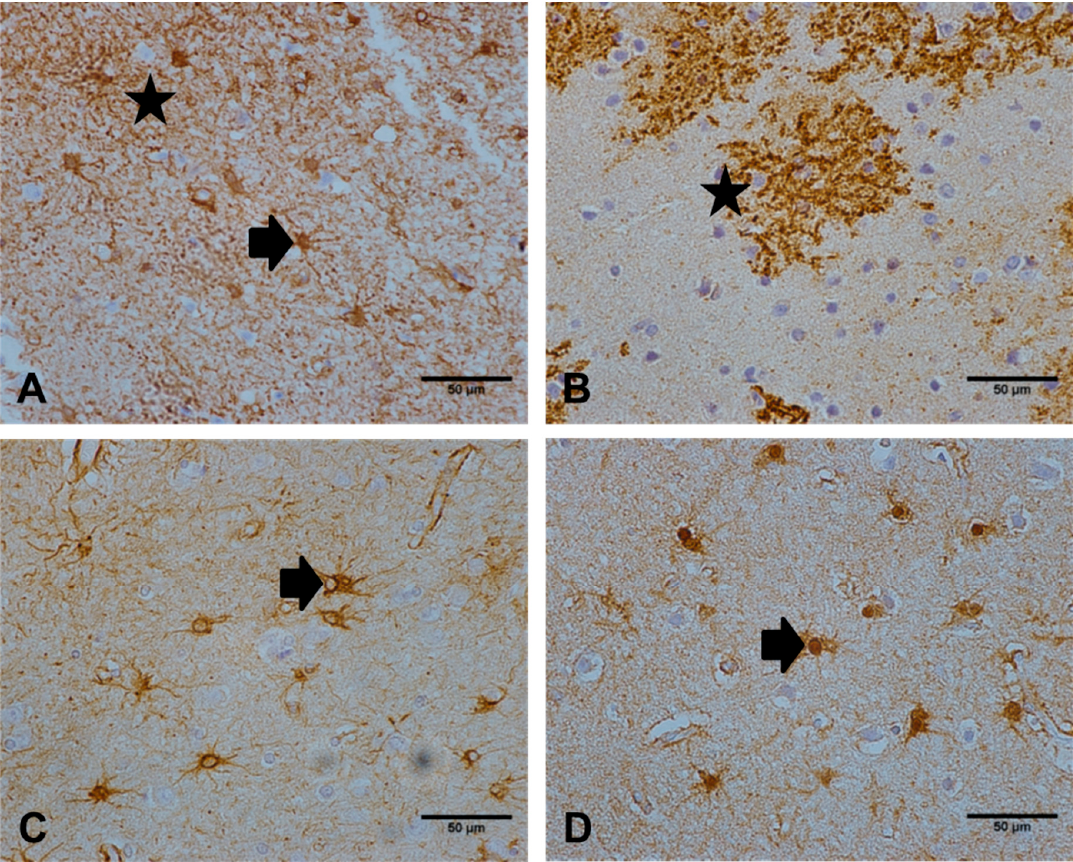
Table 1. Comparison of the immunoreactive profile (% area immunoreactivity) of the astrocyte markers NDRG2, GFAP, GS, and EAAT2 in the TCx of an ageing cohort. Astrocyte Marker